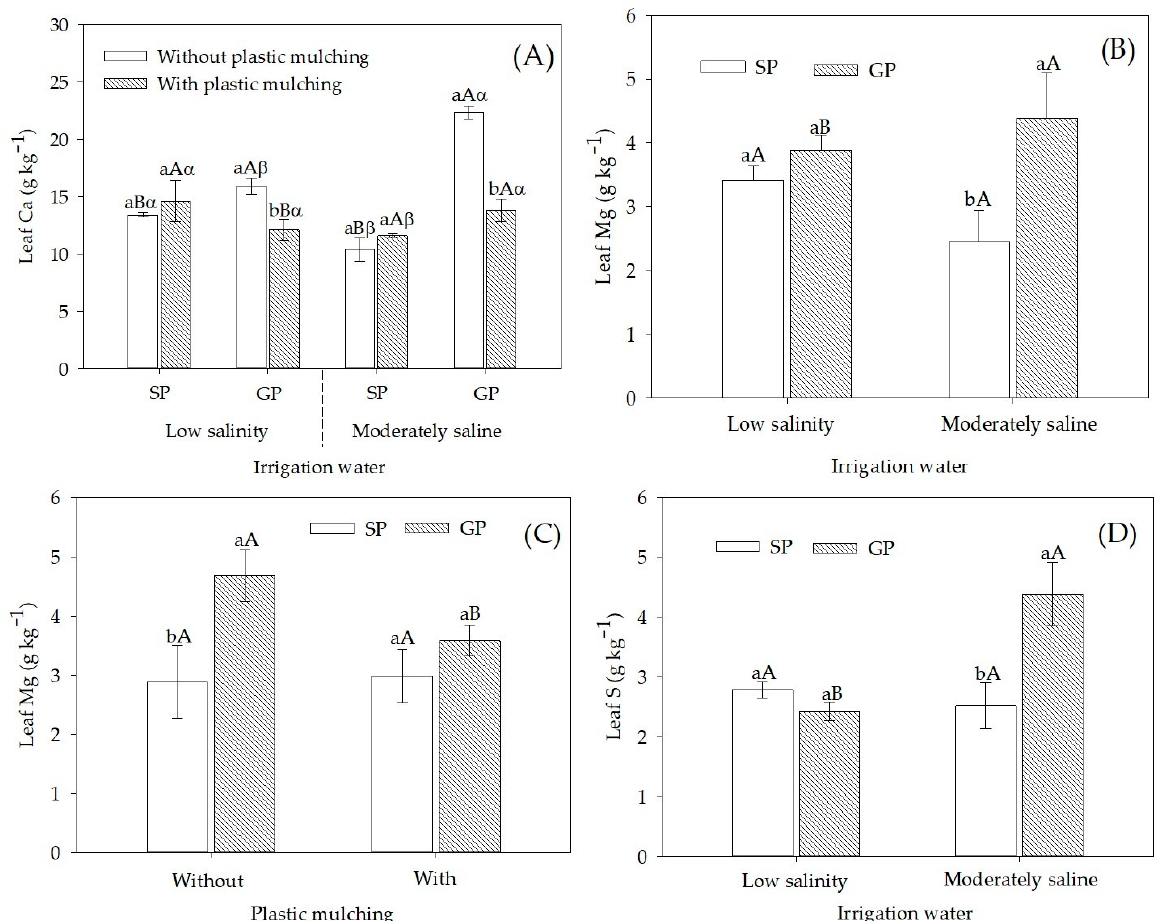
Figure 2. Concentration of macronutrients in leaves of sour passion fruit by seed-propagated and grafted propagated irrigated with low salinity and moderately saline waters with and without plastic mulching. ( A ) Ca concentration in sour passion fruit seed-propagated (SP) and grafted-propagated (GP) on Passiflora cincinnata irrigated with low salinity and moderately saline water and in soil without and with mulching plastic; ( B ) Mg concentration in sour passion fruit seed-propagated (SP) and grafted-propagated (GP) on Passiflora cincinnata irrigated with low salinity and moderately saline water; ( C ) Mg concentration in sour passion fruit seed-propagated (SP) and grafted-propagated (GP) on Passiflora cincinnata in soil without and with plastic mulching, and ( D ) S concentration in sour passion fruit seed-propagated (SP) and grafted-propagated (GP) on Passiflora cincinnata irrigated with low salinity and moderately saline water. Vertical bars represent the standard error of the mean (n = 4). Bars with the same lower-case letter are similar for soil without and with plastic mulching ( A ) or for seed propagation and grafting ( B – D ) by the F-test ( p > 0.05). Bars with the same uppercase letter are similar for seed propagation and grafting ( A ) or low salinity and moderately saline irrigation water ( B , D ) or soil without and with plastic mulching ( D ) by the F-test ( p > 0.05). Bars with the same Greek letter are similar for low salinity and moderately saline irrigation water ( A ) by the F-test ( p >